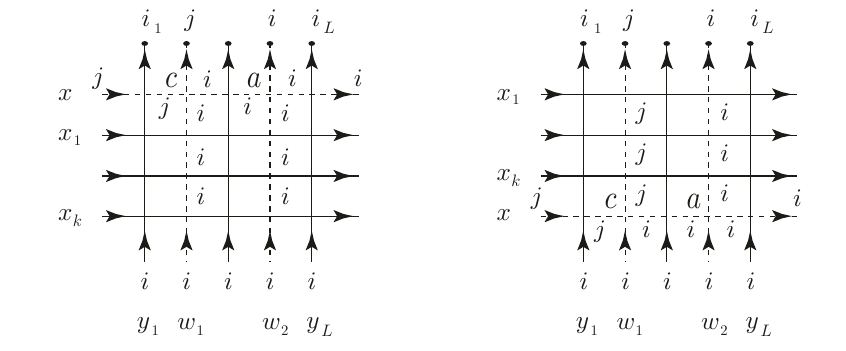
Figure 9 . Higgsed lattice configurations.